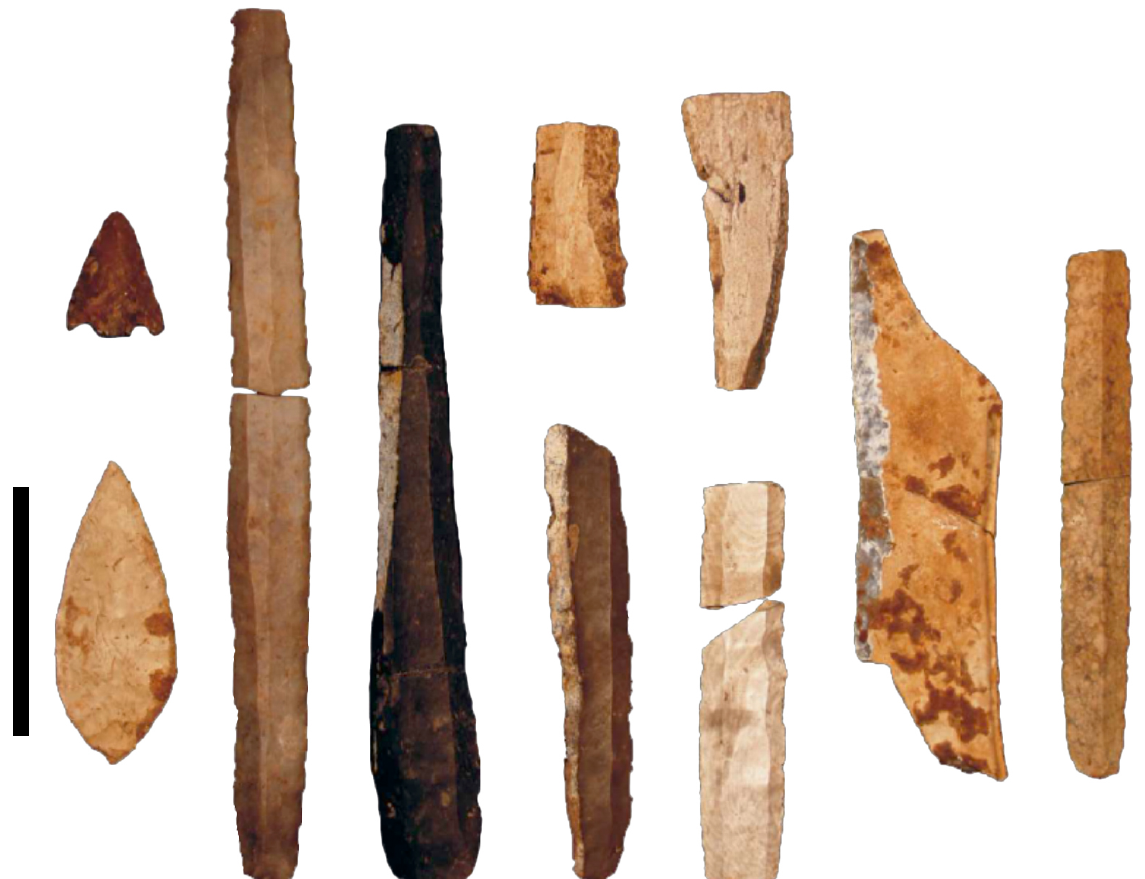
Figure 2. Part of the lithic set analysed from Cova de la Guineu. Scale bar = 3